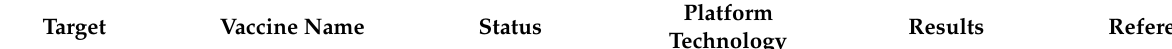
Table 2. List of results of representative mRNA vaccines and T-cell-mediated